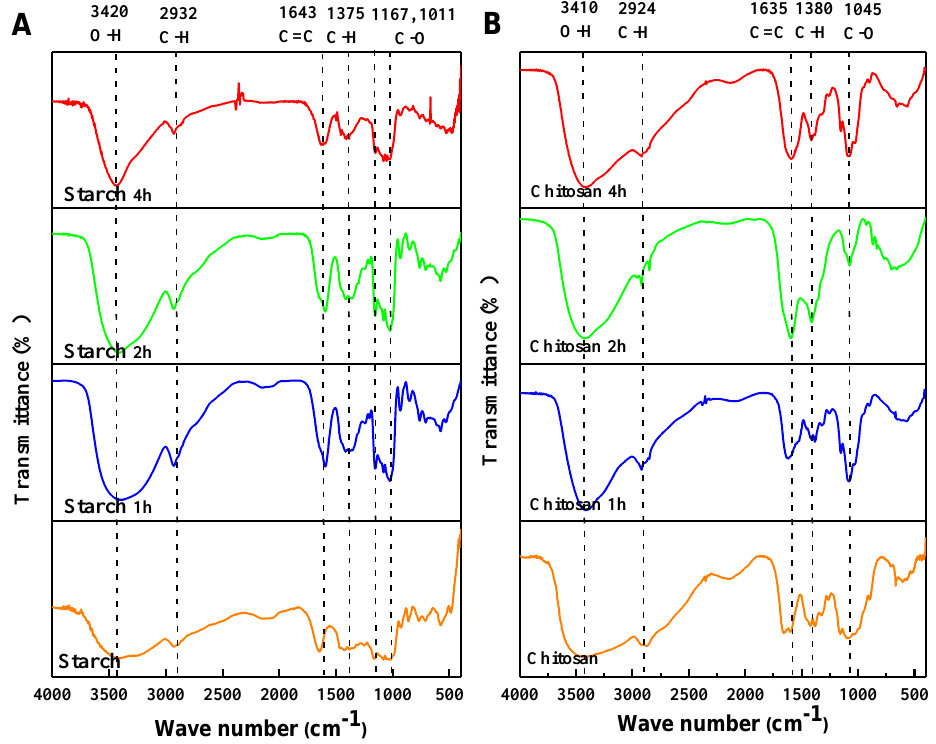
Figure 2. Fourier transform infrared (FT-IR) spectra of polysaccharide-based NSs prepared from ( A ) starch, starch NSs at 1, 2, 4 h, and ( B ) chitosan, chitosan NSs at 1, 2, 4 h.